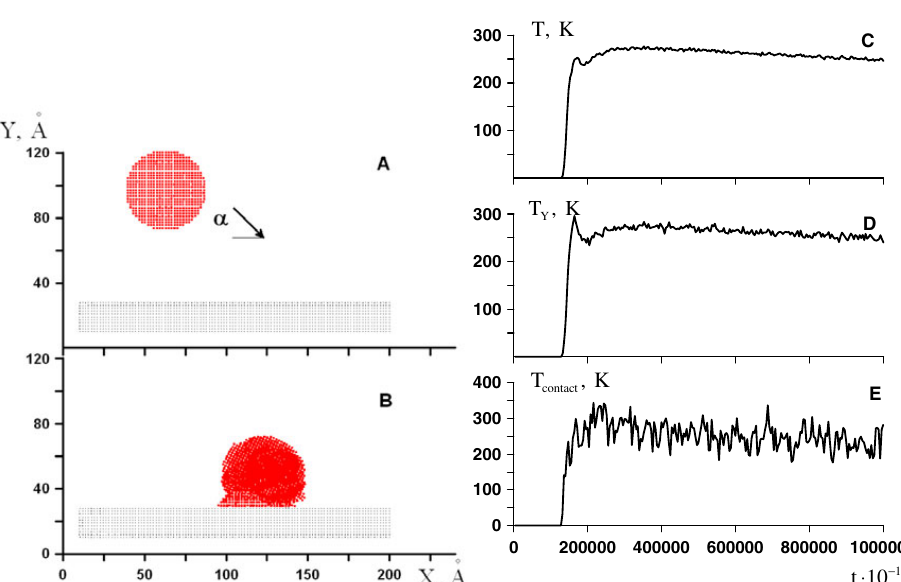
Fig. 3. Initial (A) and final (B) positions of the cluster and substrate in the XY plane. Dependences of cluster kinetic temperature (C), Y-component of cluster kinetic temperature (D) and kinetic temperature in the contact region (E) versus time. Impact angle α = 45 ◦ . Initial velocity is 500 m /